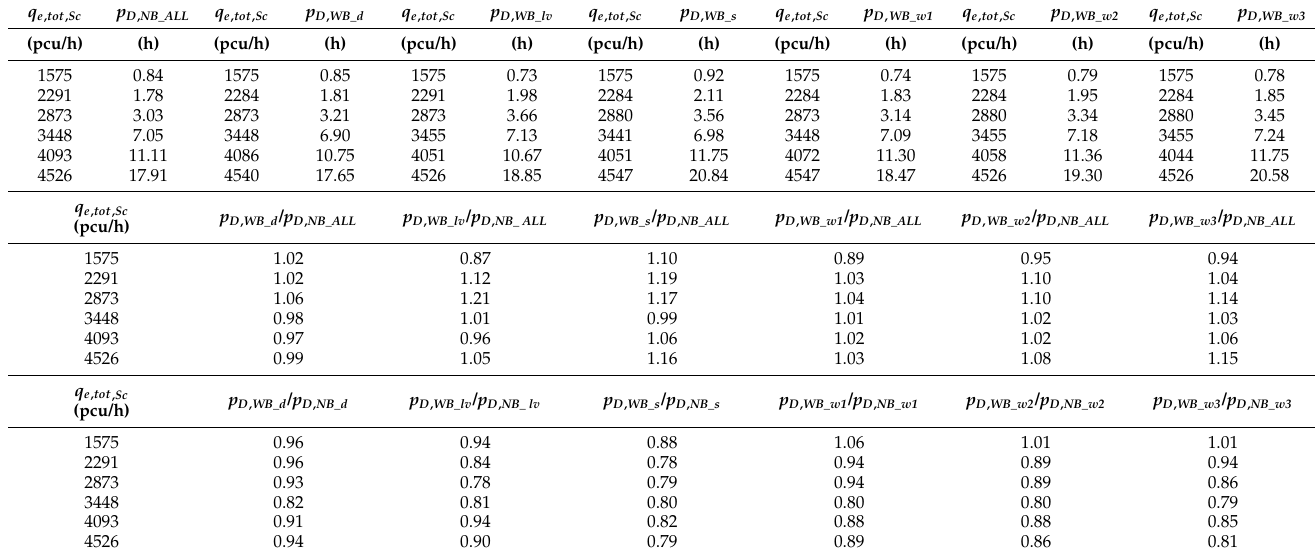
Table 4. Total delays in simulated network depending on q e , tot , Sc for simulated scenarios NB_ALL and WB_c , along with index